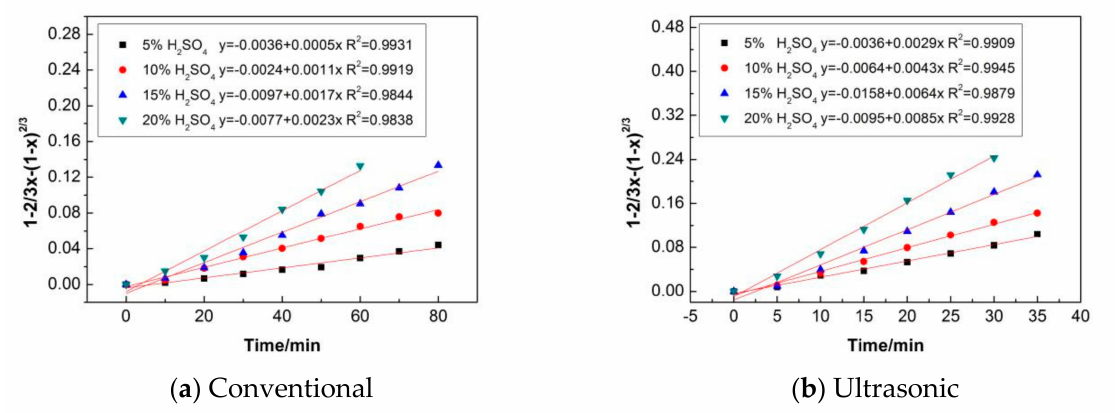
Figure 11. Fitting internal diffusion control model at different sulfuric acid